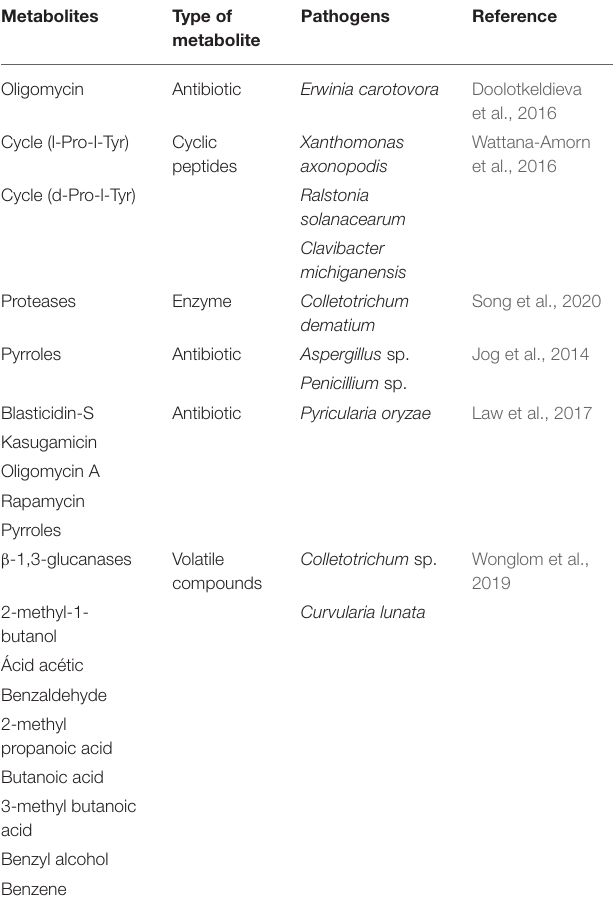
TABLE 3 | Compounds produced by Streptomyces spp. with antimicrobial activity against